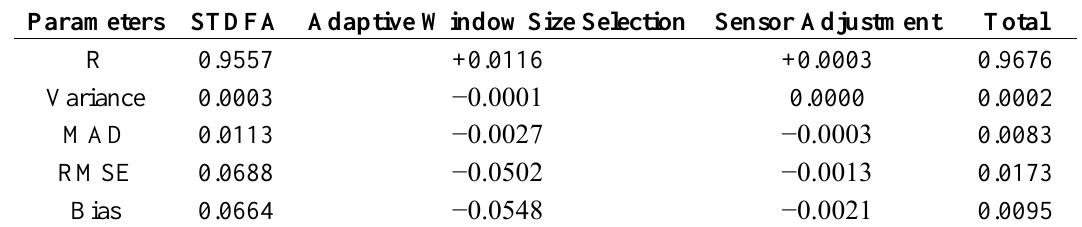
Table 7. Accuracy improvements of every step in MSTDFA method of NIR band in Luntai. Parameters